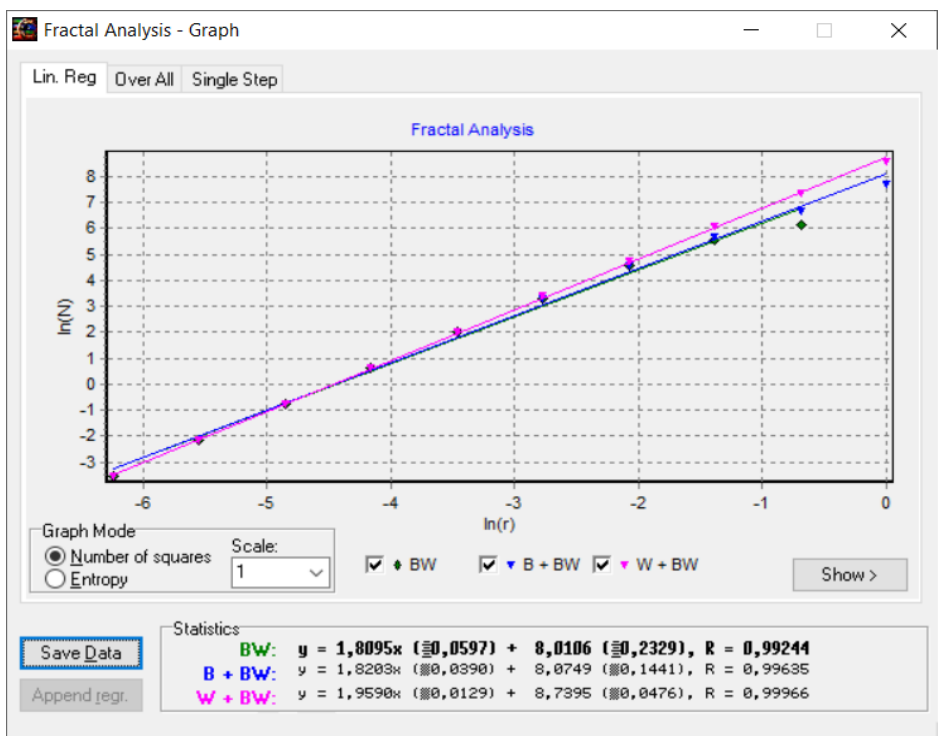
Figure 20. Voxels representation of the image in the unaffected area.